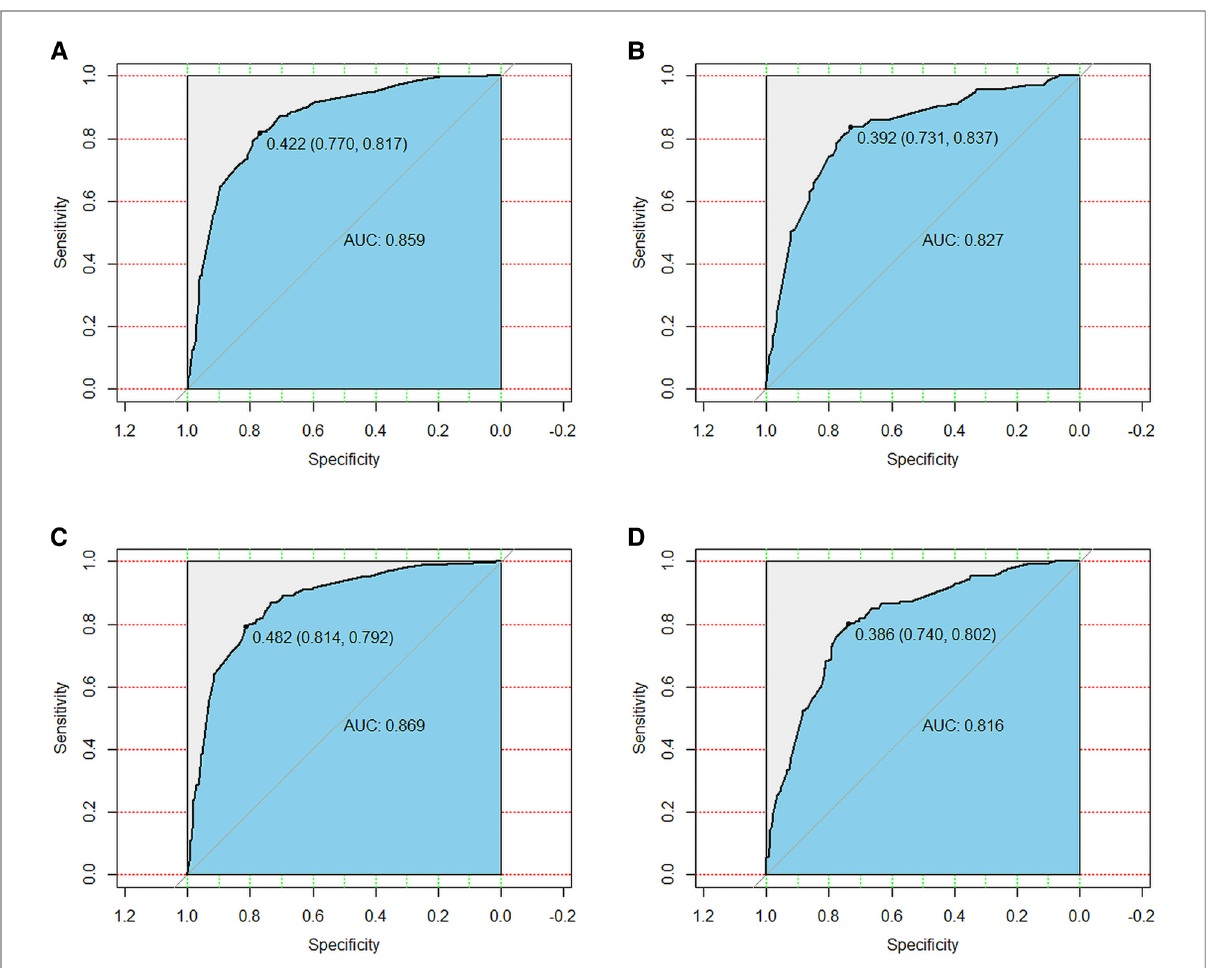
FIGURE 4 The receiver operating characteristic (ROC) curve for nomogram. ( A ) The training cohort of total early death; ( B ) The validation cohort of total early death; ( C ) The training cohort of cancer-speci fi c early death; ( D ) The validation cohort of cancer-speci fi c early death. AUC, area under the curve; ROC, receiver operating